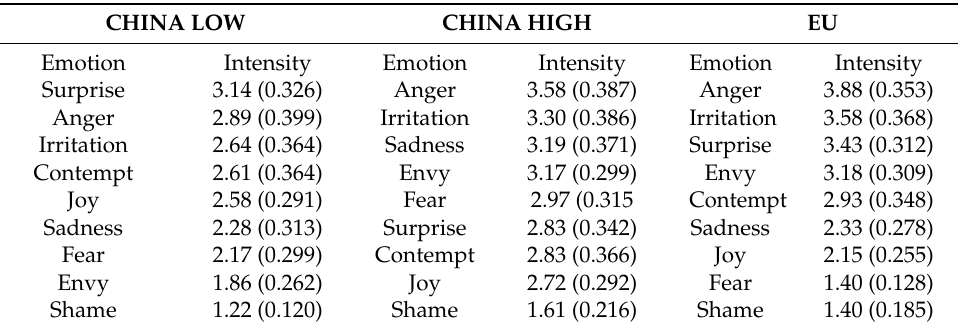
Table 3. Ranking of averaged experienced emotions.